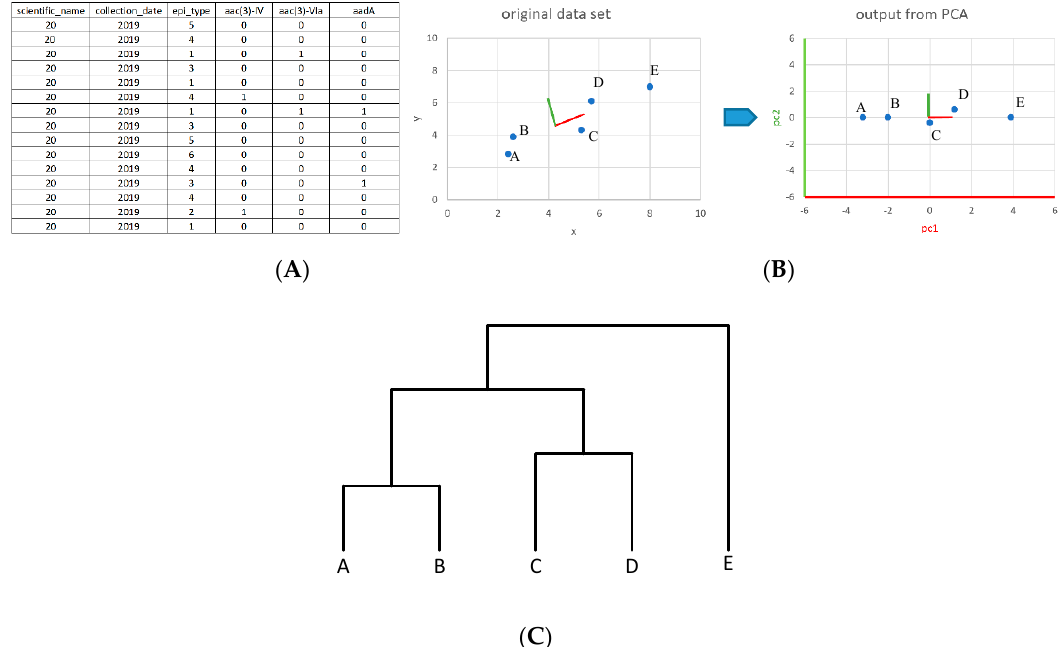
Figure 1. The general procedure of multivariate statistical analysis implemented in this study: ( A ) A portion of the data matrix extracted from NCBI Pathogen Detection Isolates Browser Database for the US; ( B ) principal component analysis was used to reduce the data matrix dimensions so that the data points (e.g., genes/pathogens/meats) can be visualized in a two dimensional space (e.g., the x - y space can be reduced to the PC1 space); ( C ) the hierarchical clustering approach was used to separate the data points on the basis of a two-dimensional space produced by principal component analysis. Simple diagrams are used in ( A – C ) to illustrate the general steps for principal component analysis and hierarchical clustering.